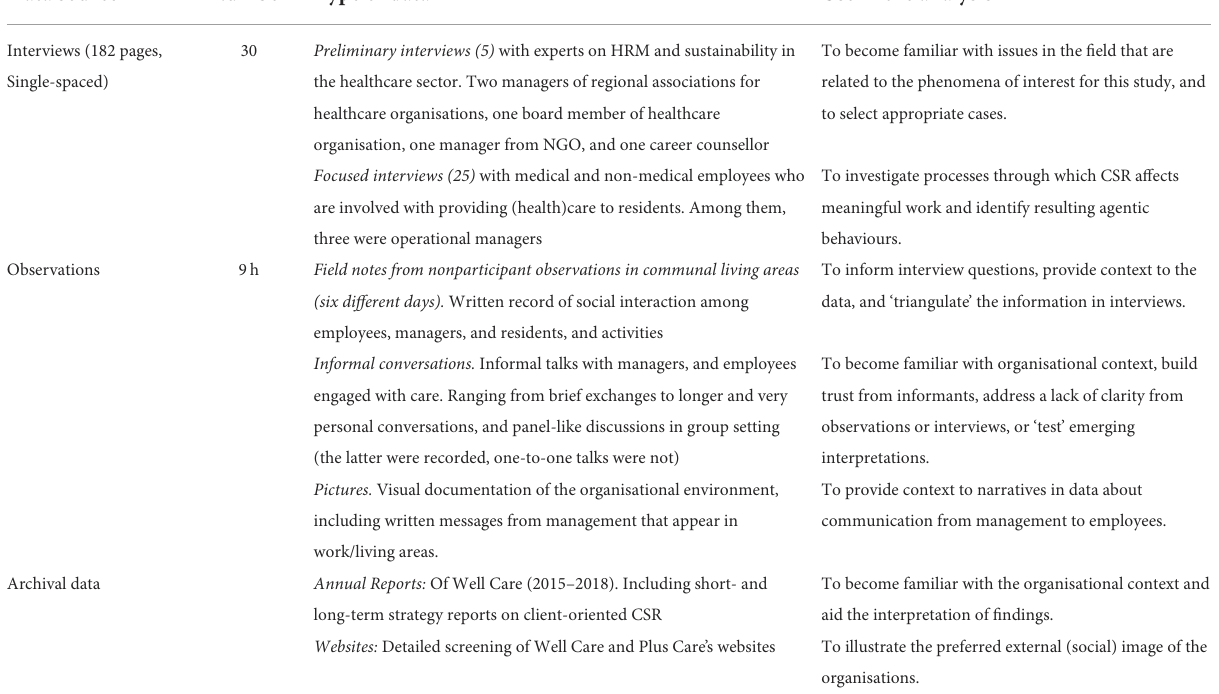
TABLE 2 Data sources and